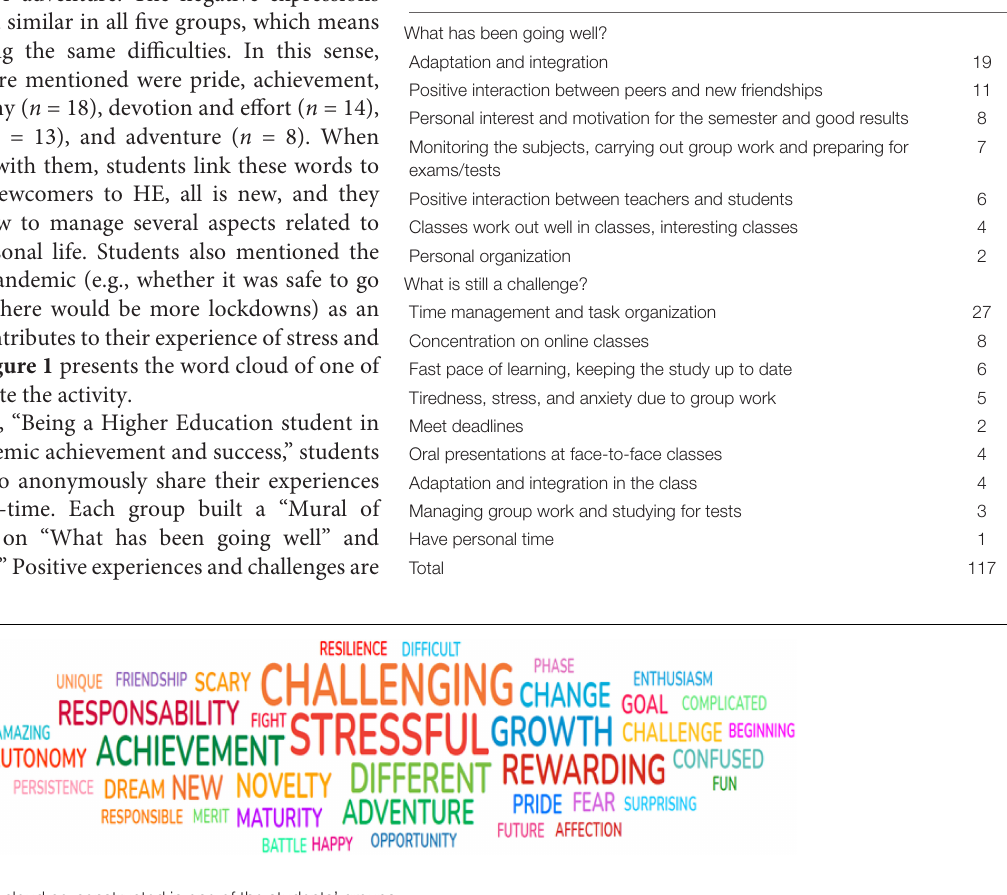
FIGURE 1 | Example of word cloud co-constructed in one of the students’